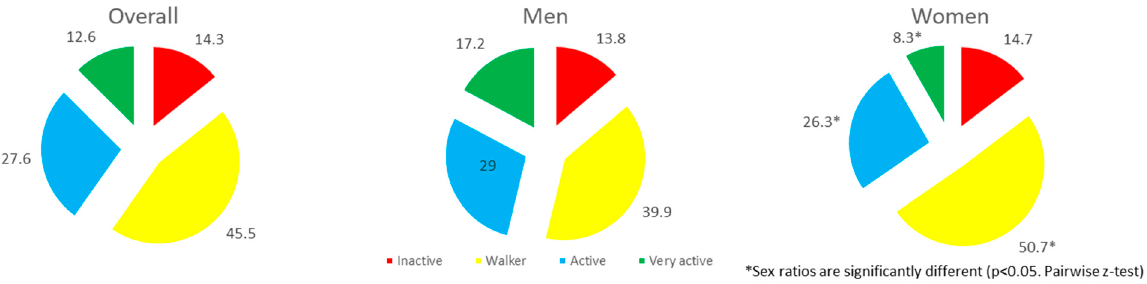
Figure A2. Level of physical activity in the general Spanish population and according to sex.